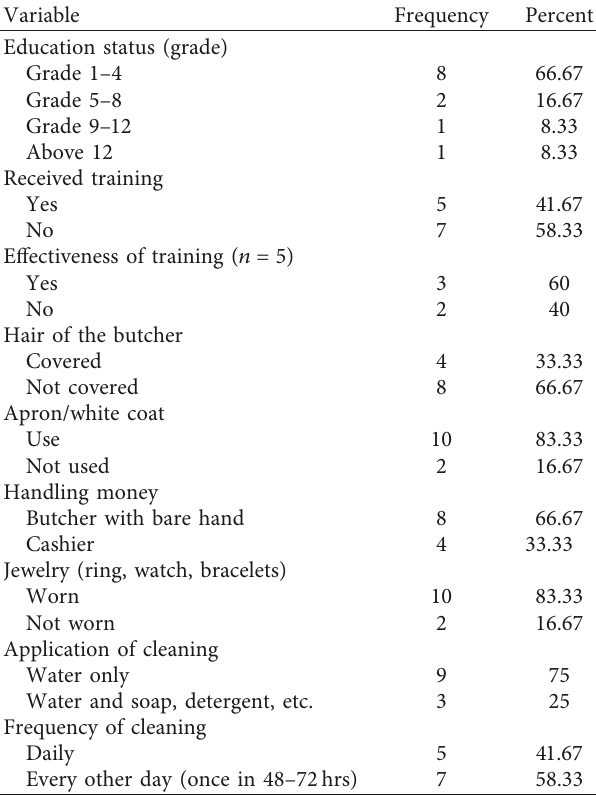
Table 2: Summary of the butcher shops workers responses ( n �